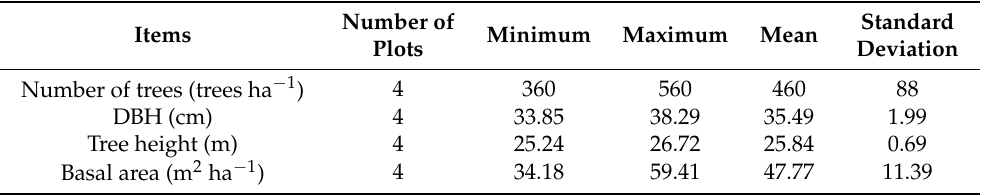
Table 2. Diameter at breast height (DBH), tree height, number of trees, basal area for the Konishii fir plantation of this study area based on the sample